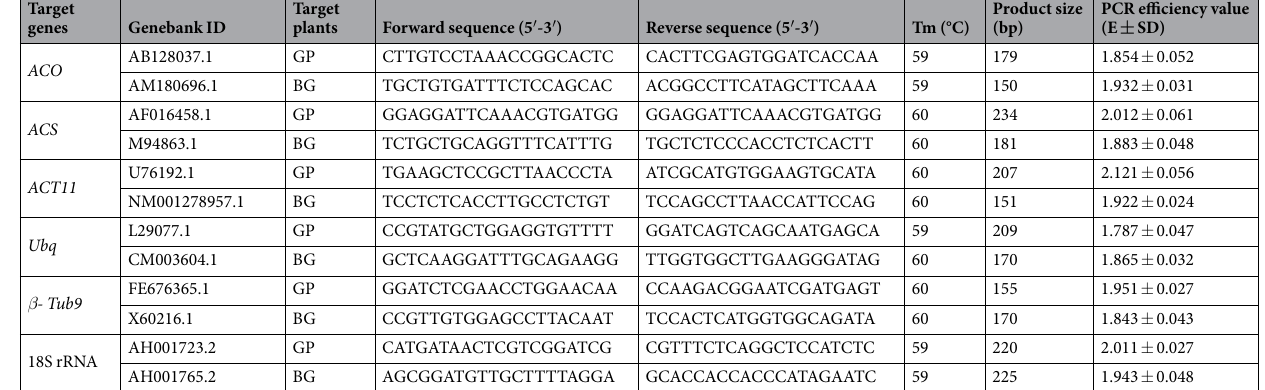
Table 5. Primers sequences and other properties used in real time PCR expression analysis. Table key: BG - black gram, GP - garden pea, Tm- melting